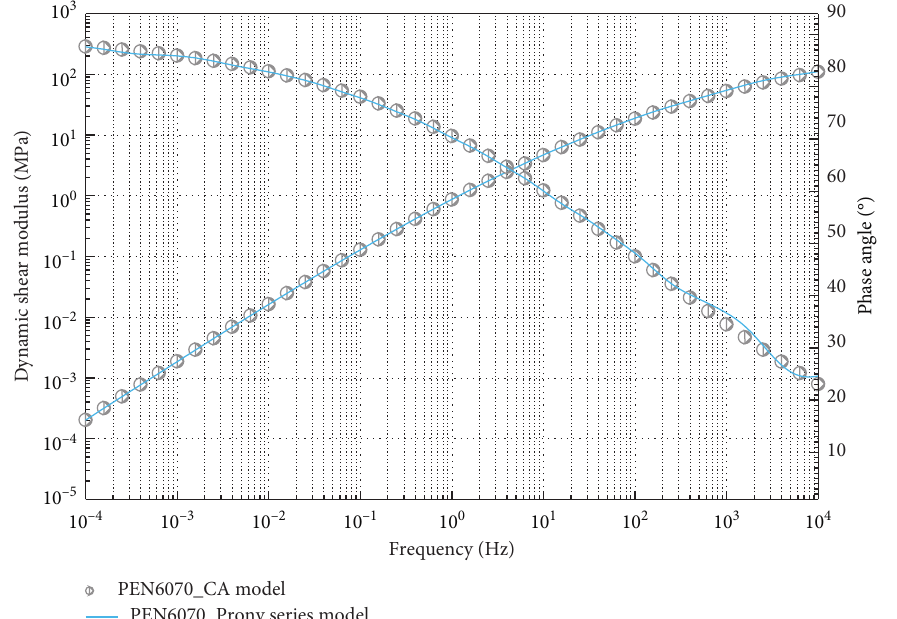
Figure 6: Dynamic shear modulus and phase angle master curves fitted by the CA model and the corresponding Prony series for Pen6070 at 25 ° C. Determine the material properties and thickness of coating layer